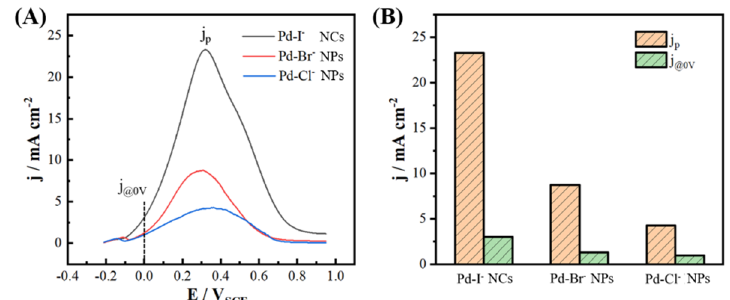
Figure 4. Comparison of electrocatalytic activity of the Pd nanoparticles as synthesized. Pd-I − NCs (Pd nanocubes prepared using the standard synthesis, as shown in Figure 1A), Pd-Cl − NPs (as shown in FigureS2A), and Pd-Br − NPs (as shown in Figure S2B) towards formic acid oxidation. ( A ) Linear sweep voltammetry (LSV) recorded at 50 mV s −1 in 0.25 M HCOOH + 0.25 M HClO 4 . Currents were normalized to the electrochemical surface area of the catalysts. ( B ) Comparison of the oxidation current densities at the peak potential ( j p ) and at 0 V ( j 0V ).